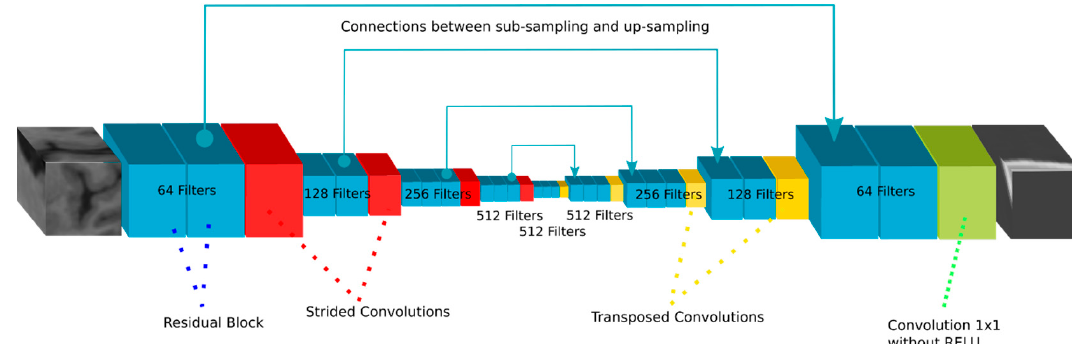
Figure 4. Schematic representation of the Franken-net architecture. Our implementation in TensorFlow processes 3D cubes of the MR T1-weighted input image to generate a pseudo-CT cube with the same shape as the input.